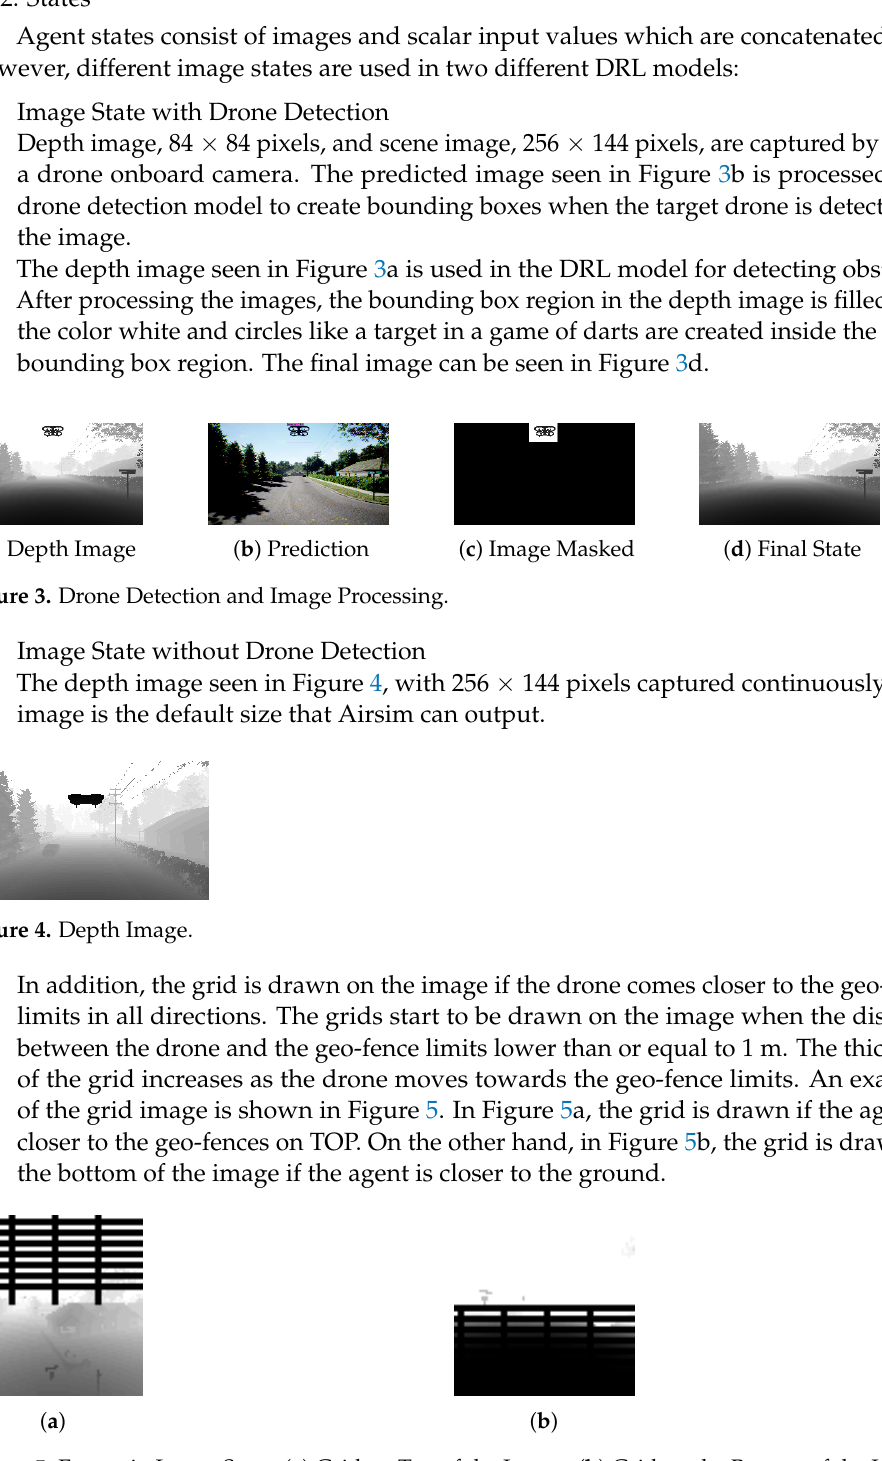
Figure 5. Fences in Image State. ( a ) Grid on Top of the Image. ( b ) Grid on the Bottom of the